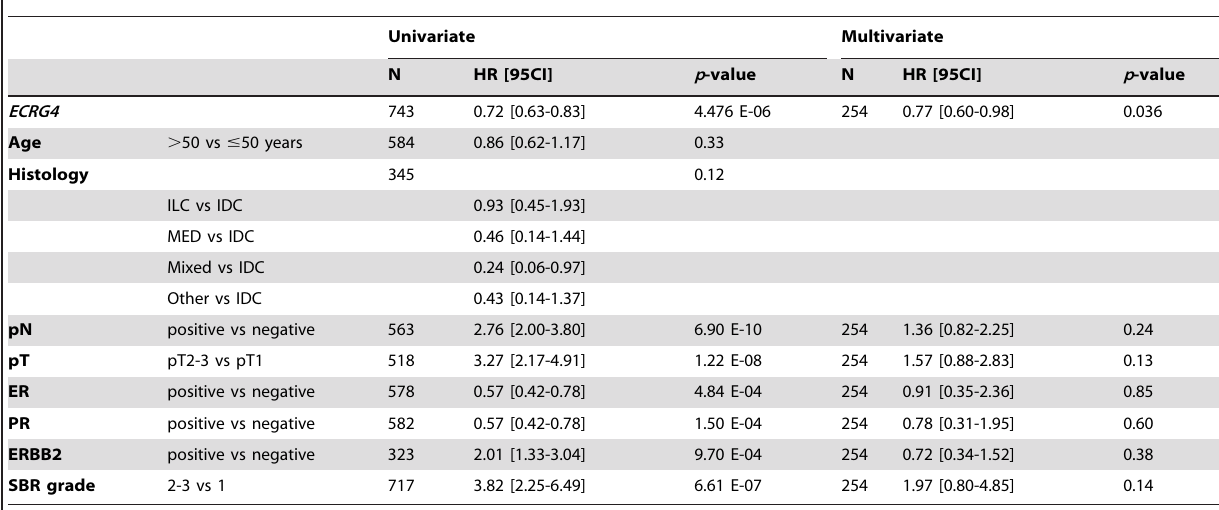
Table 4. Overall survival (OS), Cox regression